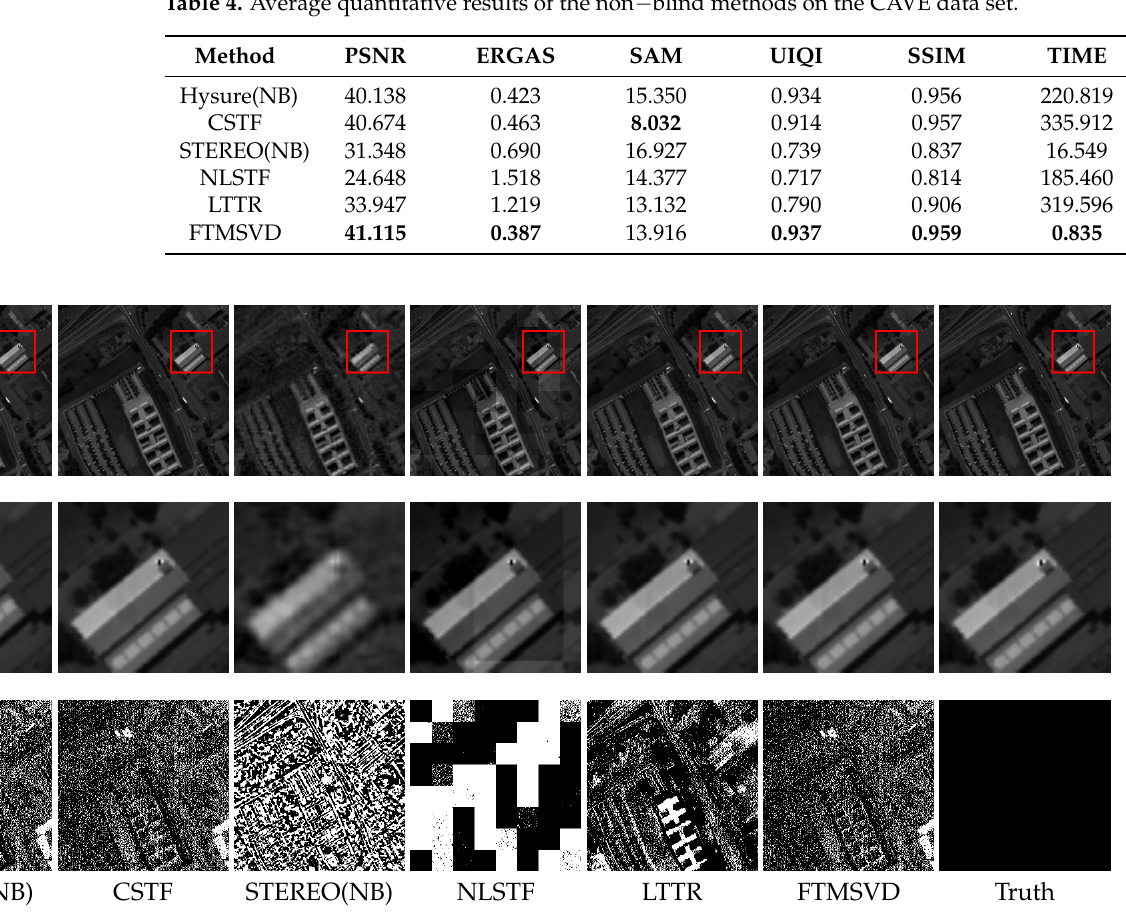
Figure 3. The first row shows the fused images by the competing method for Pavia University at band 30. The second row shows the magnified version of the marked area. The third row shows the error images of the test methods for Pavia University at band